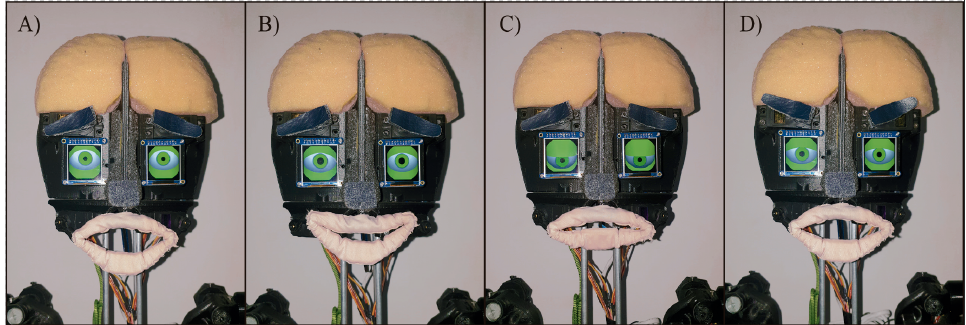
Figure 11. Emotions performed by CASTOR’s face: ( A ) wonder, ( B ) happiness, ( C ) sadness, and ( D )